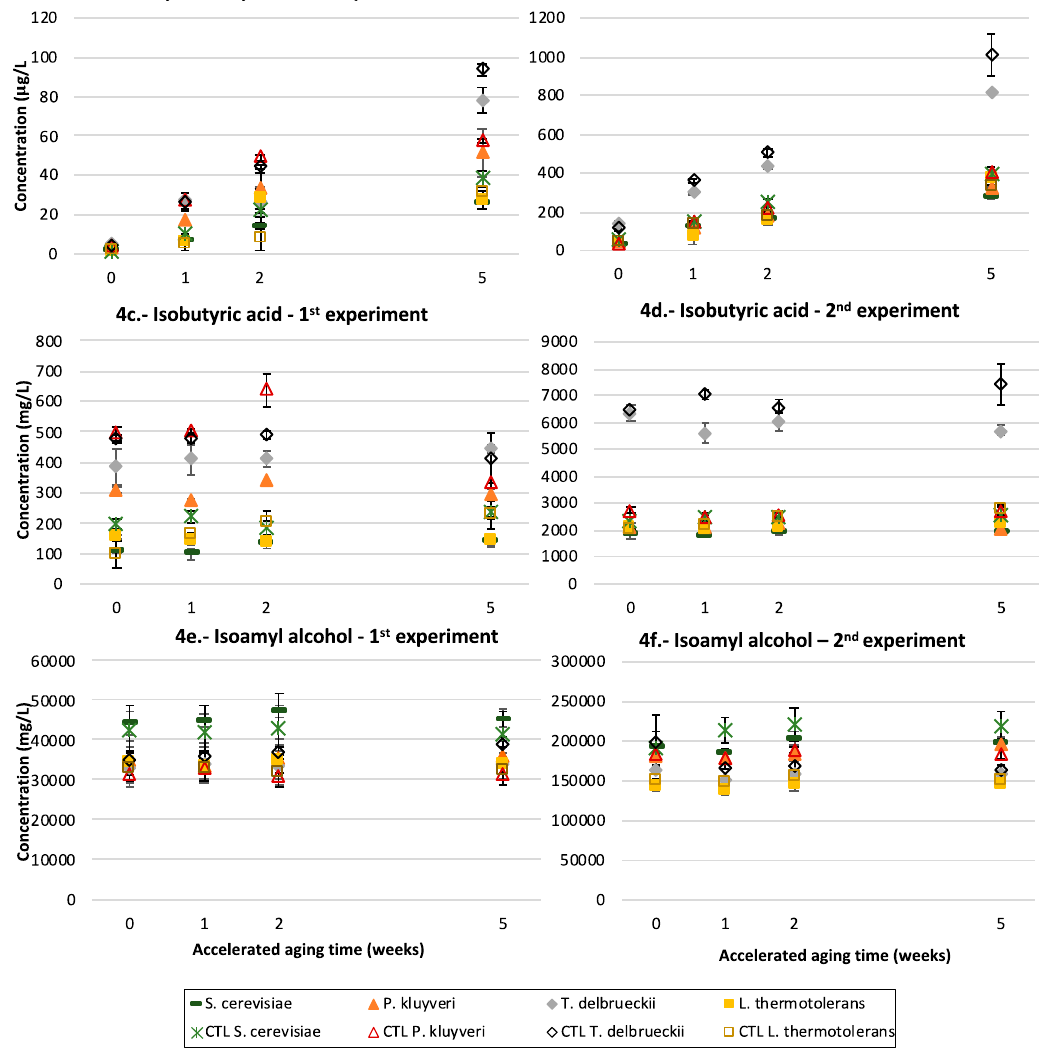
Figure 4. The branched acids and their ethyl esters and isoamyl alcohol: the evolution of ( a , b ) ethyl isobutyrate, ( c , d ) isobutyric acid and ( e , f ) isoamyl alcohol in the Riesling (1st experiment) and Garnacha (2nd experiment) experiments after 1, 2 and 5 weeks of accelerated aging and according to the yeast strain that carried out the fermentation: S. cerevisiae or P. kluyveri , T. delbrueckii and L. thermotolerans sequentially inoculated with S. cerevisiae . The samples without precursors are indicated as CTL.